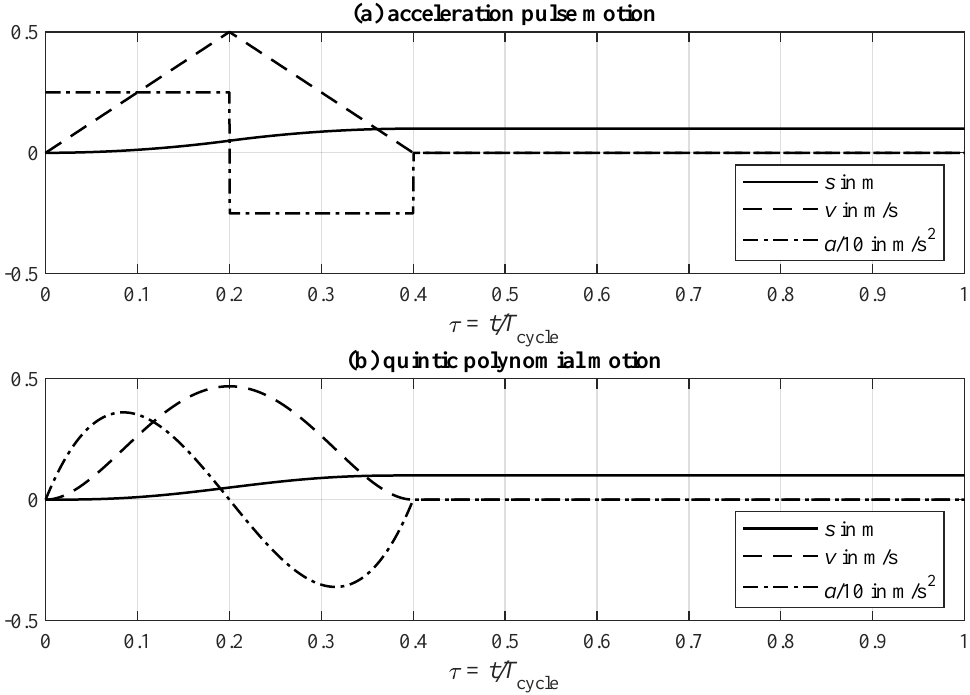
Figure 4. Applied motion profiles calculated for a cycle time of T cyle = 1s, displayed over the normalized time τ : ( a ) acceleration pulse motion is used for parameter identification, and ( b ) polynomial motion is used for generating validation